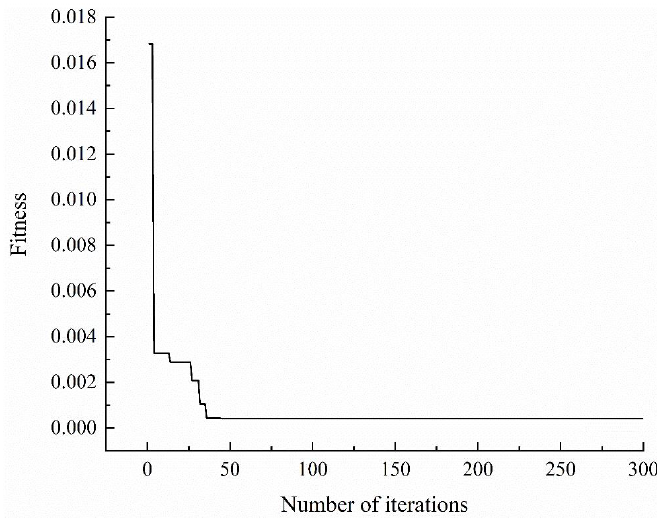
Figure 5. Error convergence curve.